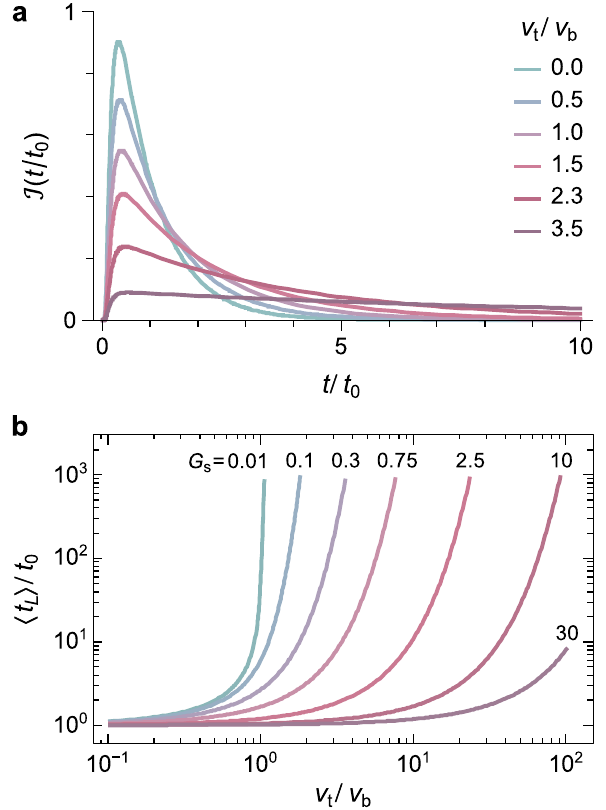
Figure 3. Effect of advection on distribution and age of sediment particles. ( a ) Modelled impulse response of tracer particles, with t 0 = L / v b being the mean transit time of regular sediment particles through the SML, for selected ratios between the tracer segregation velocity v t and the burial velocity v b . ( b ) Transit time enhancement as a function of v t / v b for selected values of the inverse Péclet number G s of the bulk